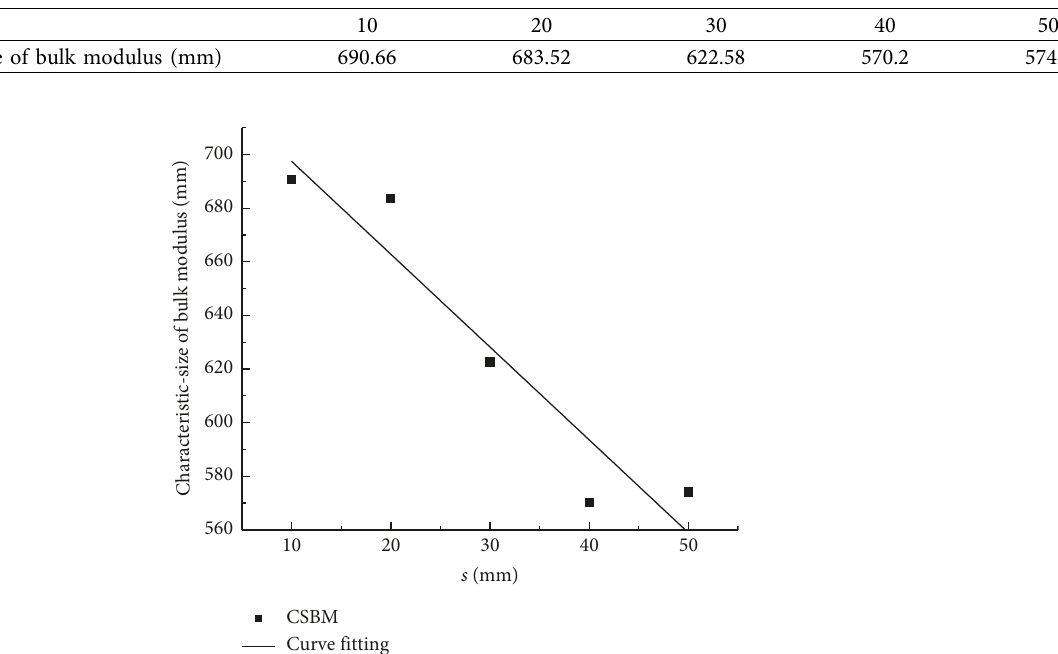
Figure 6: Fitting curves of parameters and PJS. (a) Parameter d; (b) parameter f; (c) parameter g . Table 9: Relationship between CSBM and PJS.